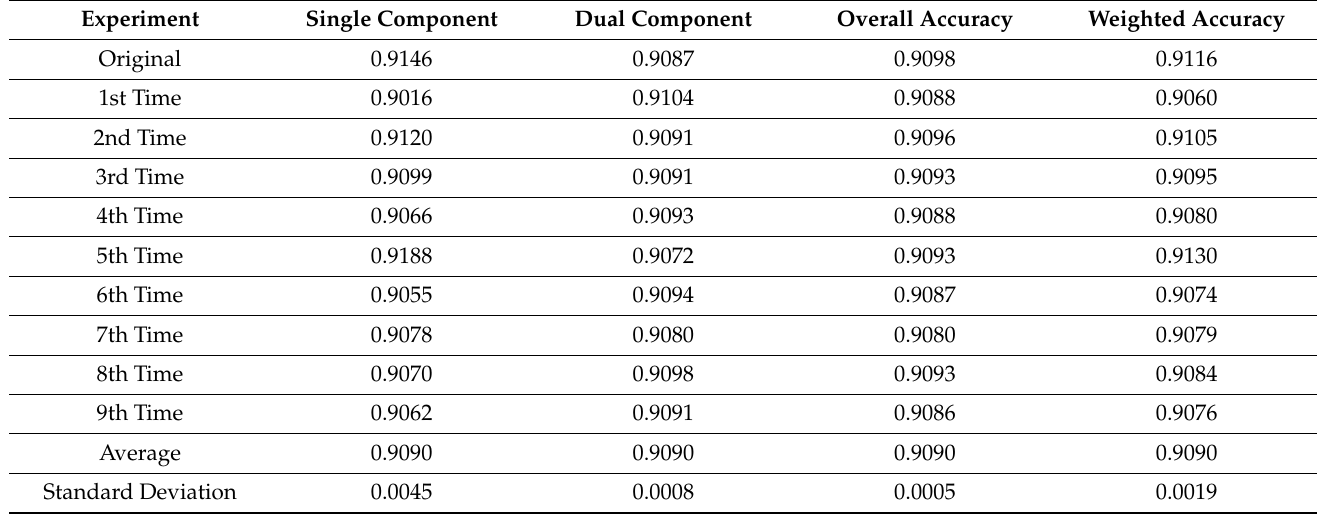
Table A1. The classification accuracy of the original experiment and five additional